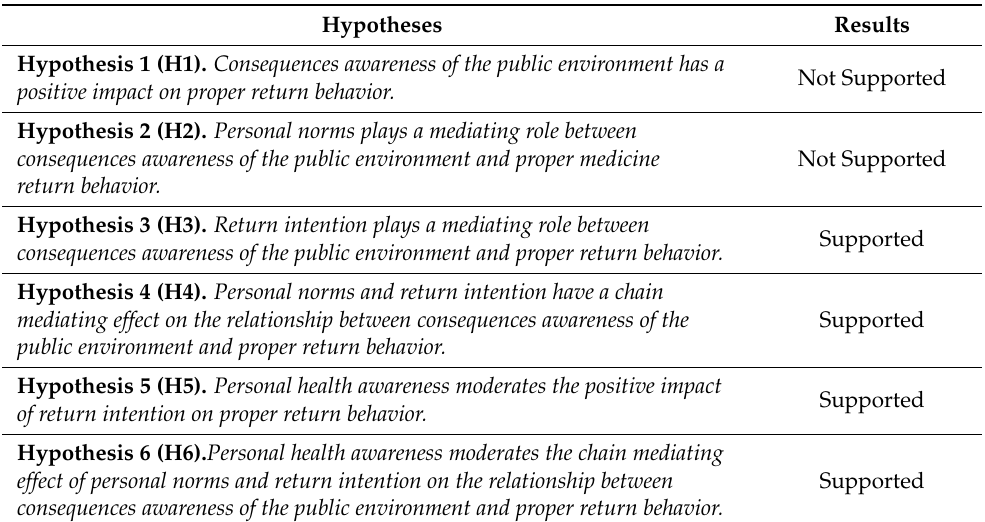
Table 5. Results of hypothesis